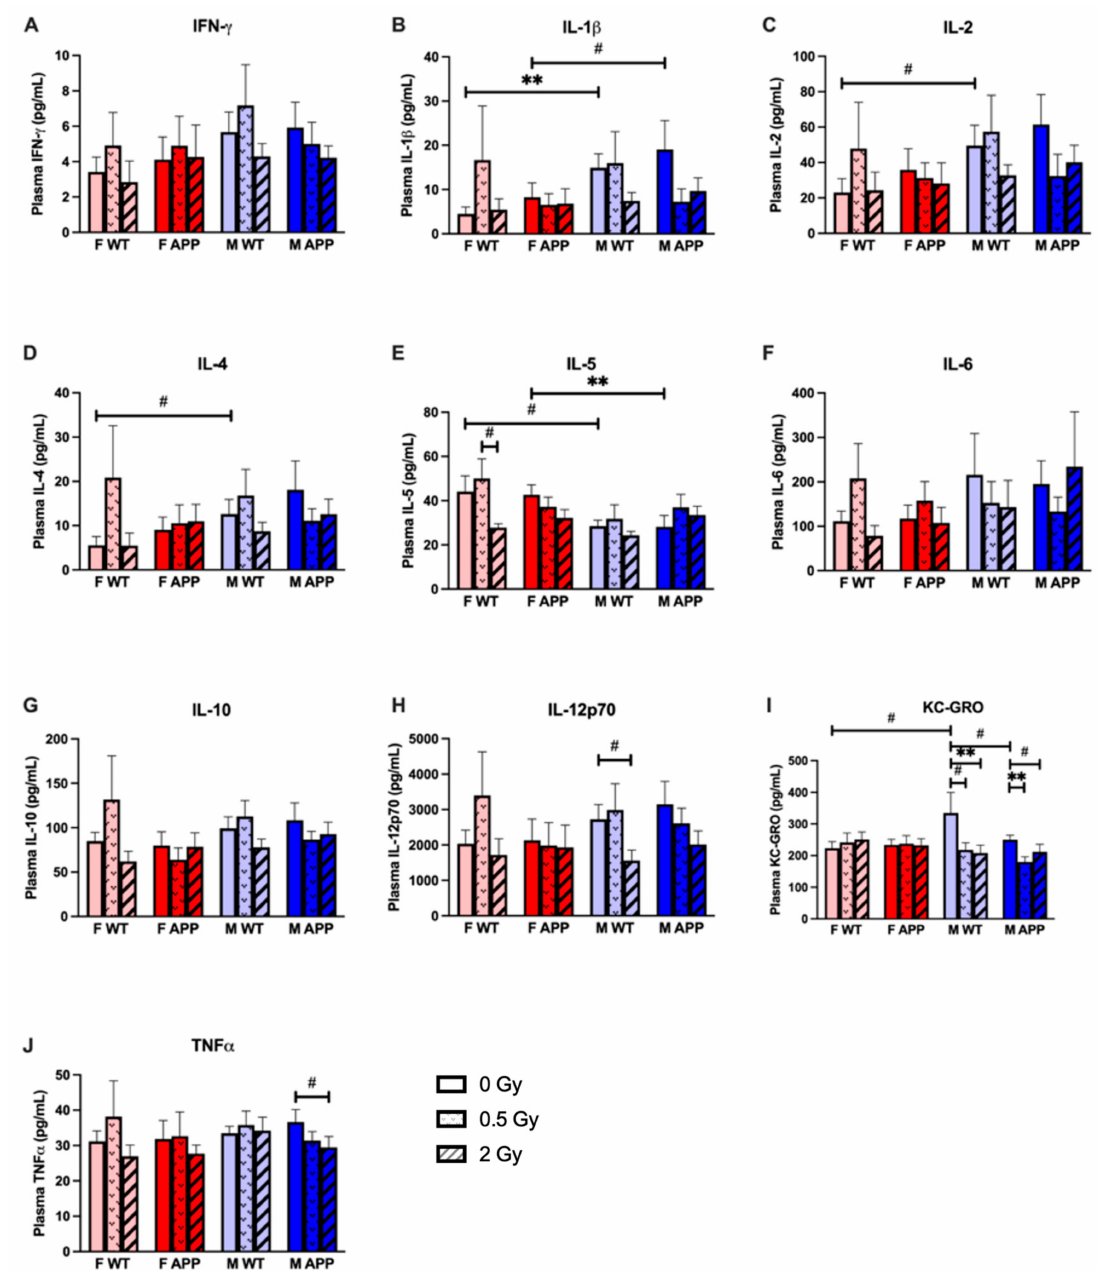
Figure 7. Plasma levels of 10 inflammation-related cytokines 9 months after proton irradiation measured by MSD ELISA ( A ) IL- γ , ( B ) IL-1 β , ( C ) IL-2, ( D ) IL-4, ( E ) IL-5, ( F ) IL-6, ( G ) IL-10, ( H ) IL- 12p70, ( I ) KC-GRO, and ( J ) TNF- α ( n = 10–16 mice/group). Modestly lowered levels of KC-GRO were observed in irradiated Tg and WT male mice compared with unirradiated controls. TNF α was also lowered after irradiation in Tg males only. Additionally, WT male mice saw a statistical trend for a decrease in plasma levels of IL-12p70 after 2 Gy of proton irradiation compared to unirradiated controls. #: p < 0.1, **: p < 0.01. Data were analyzed by ANOVA with unequal variance corrected (Welch’s) and non-parametric (Kruskal-Wallis) versions as required. Unirradiated control groups were compared by planned, 2-tailed t -tests independent of ANOVA with unequal variance corrected (Welch’s) and non-parametric (Mann-Whitney) versions as